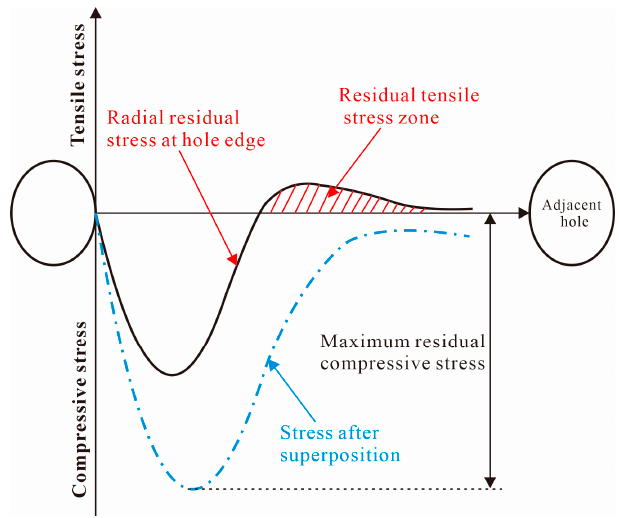
Figure 20. Residual stress distribution in the right hole radial direction for a three-hole specimen with triple aperture spacing (SSCE from left to right).